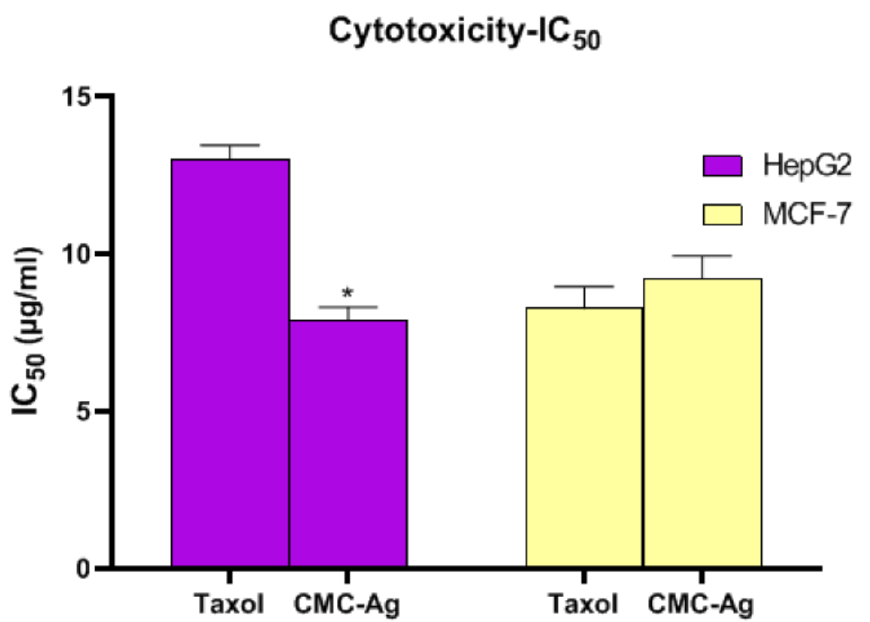
Figure 4. In-vitro cytotoxic activities of CMC-AgNPs against MCF-7 and HepG2 cell lines. The results are shown as the mean ± SD. * Significantly different from the Taxol group at p <